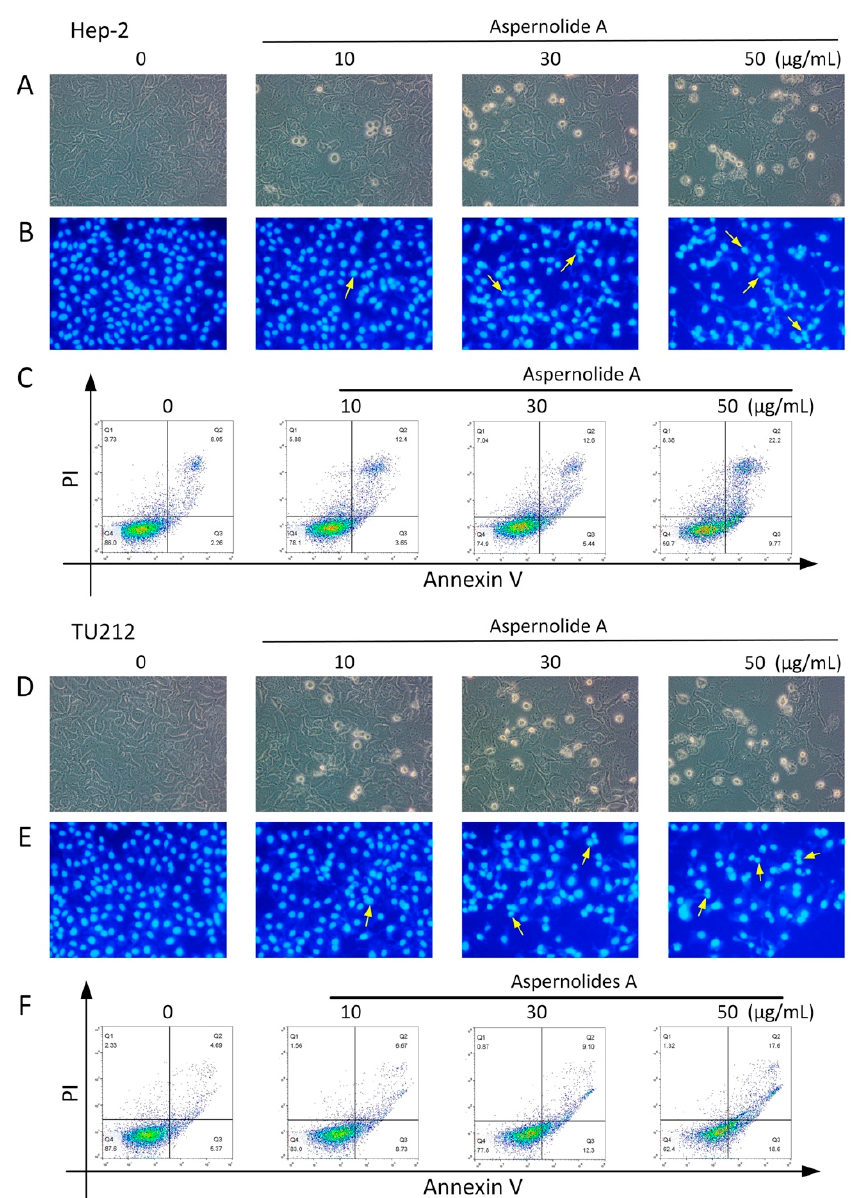
Figure 4. Observation of morphological changes and apoptosis in Hep-2 and TU212 cells with aspernolide A. ( A , D ) The morphology of Hep-2 and TU212 cells were photographed under an inverted-phase contrast microscope (80 × ). ( B , E ) The morphology of Hep-2 and TU212 cells were photographed under a fluorescence microscope (80 × ) with Hoechst 33258. ( C , F ) Hep-2 and TU212 cells were treated with aspernolide A for 12 h, then stained with Annexin V/PI staining and then evaluated by flow cytometry.